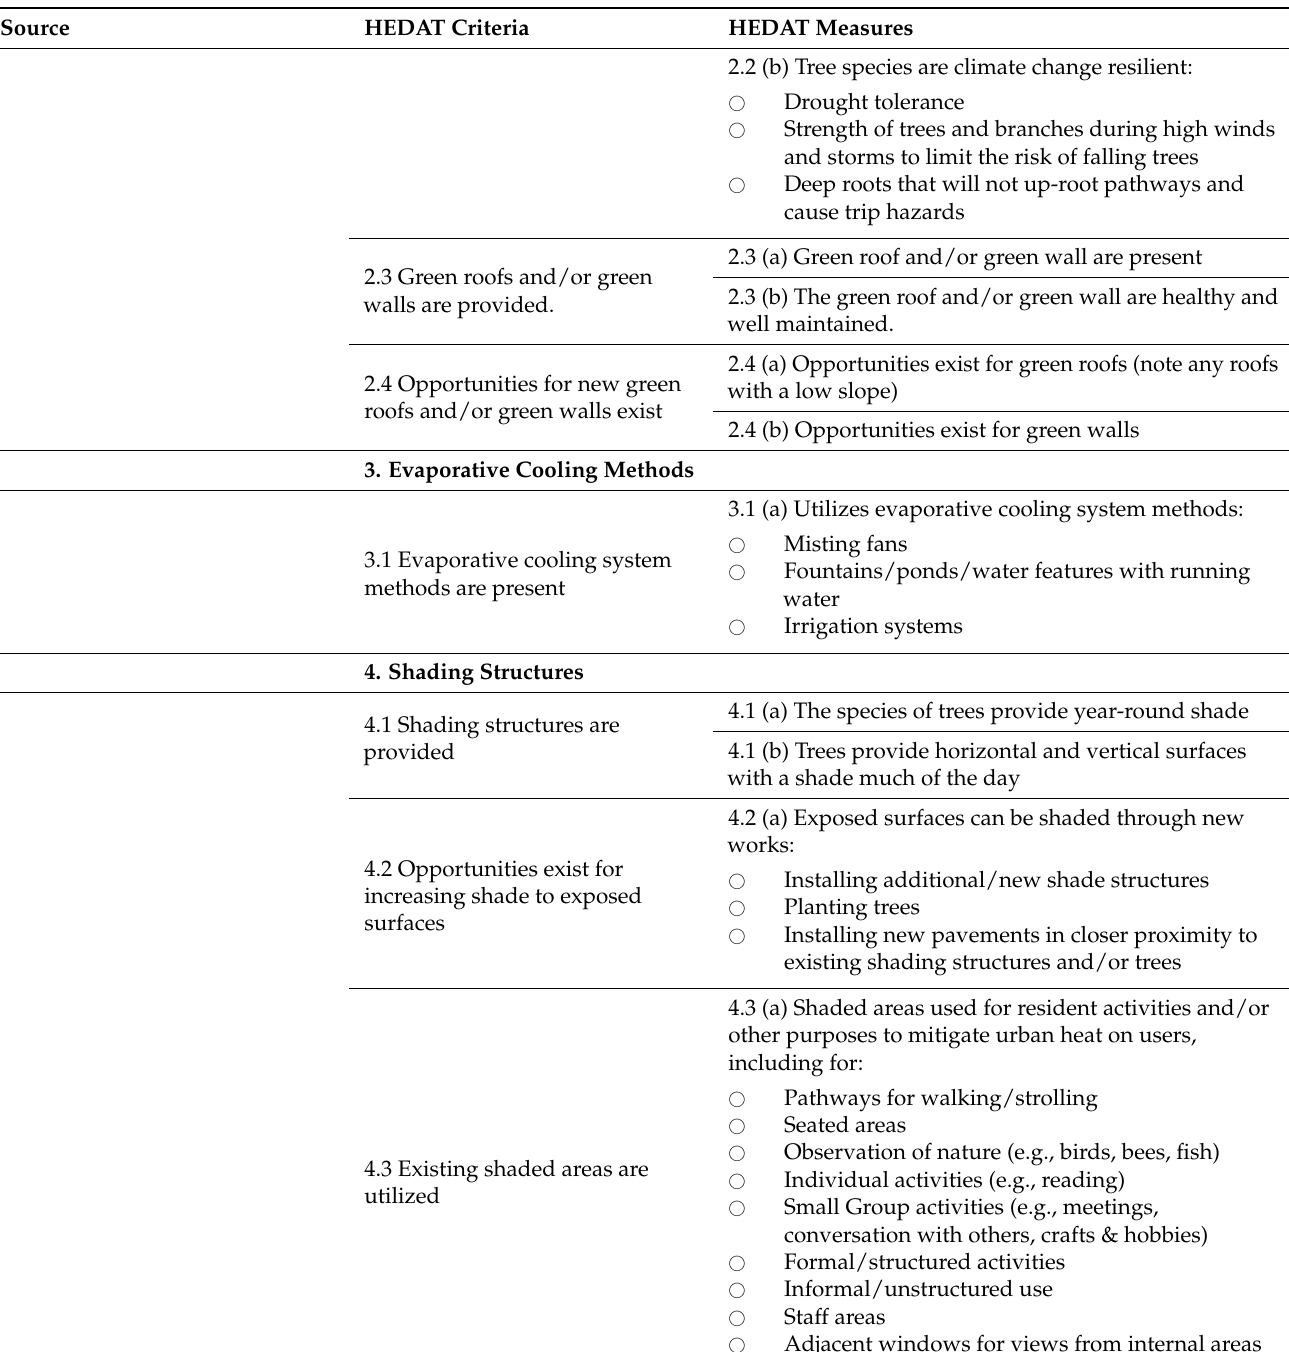
Table 1. Cont. Source HEDAT Criteria HEDAT